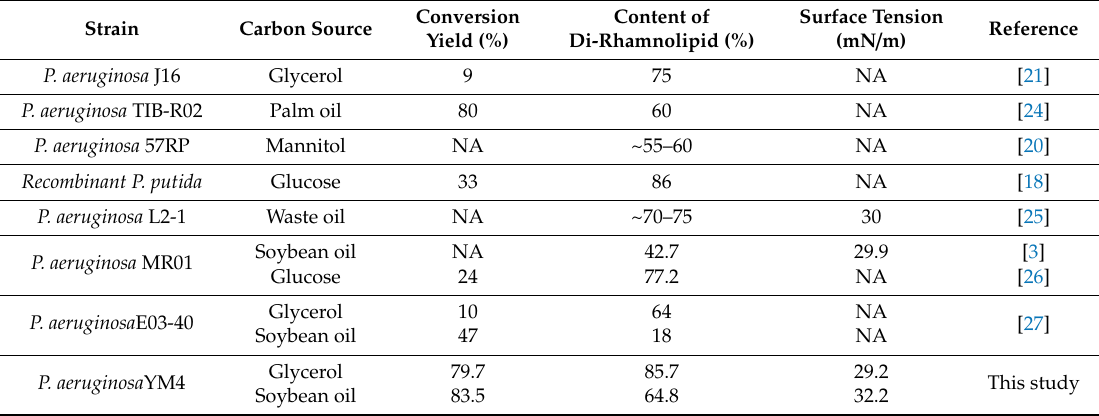
Table 5. The rhamnolipid products and di-rhamnolipid contents from various strains. Strain Carbon Source